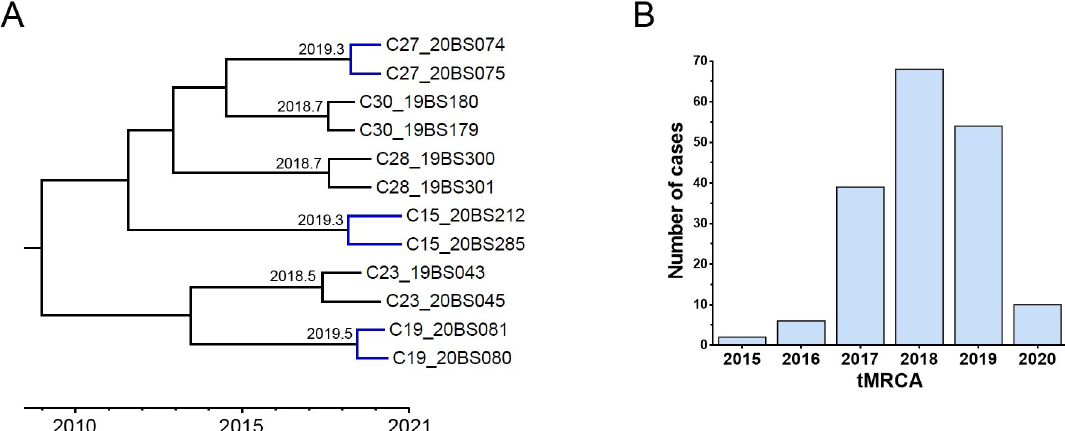
Fig 4. Distribution of tMRCA in the HIV-1 molecular network. A, Example inference of recent infection events. In the MCC tree, the tMRCA of the blue clades was post-2019, and these clades were associated with recent infection events. B, Distribution of tMRCA in the HIV-1 molecular